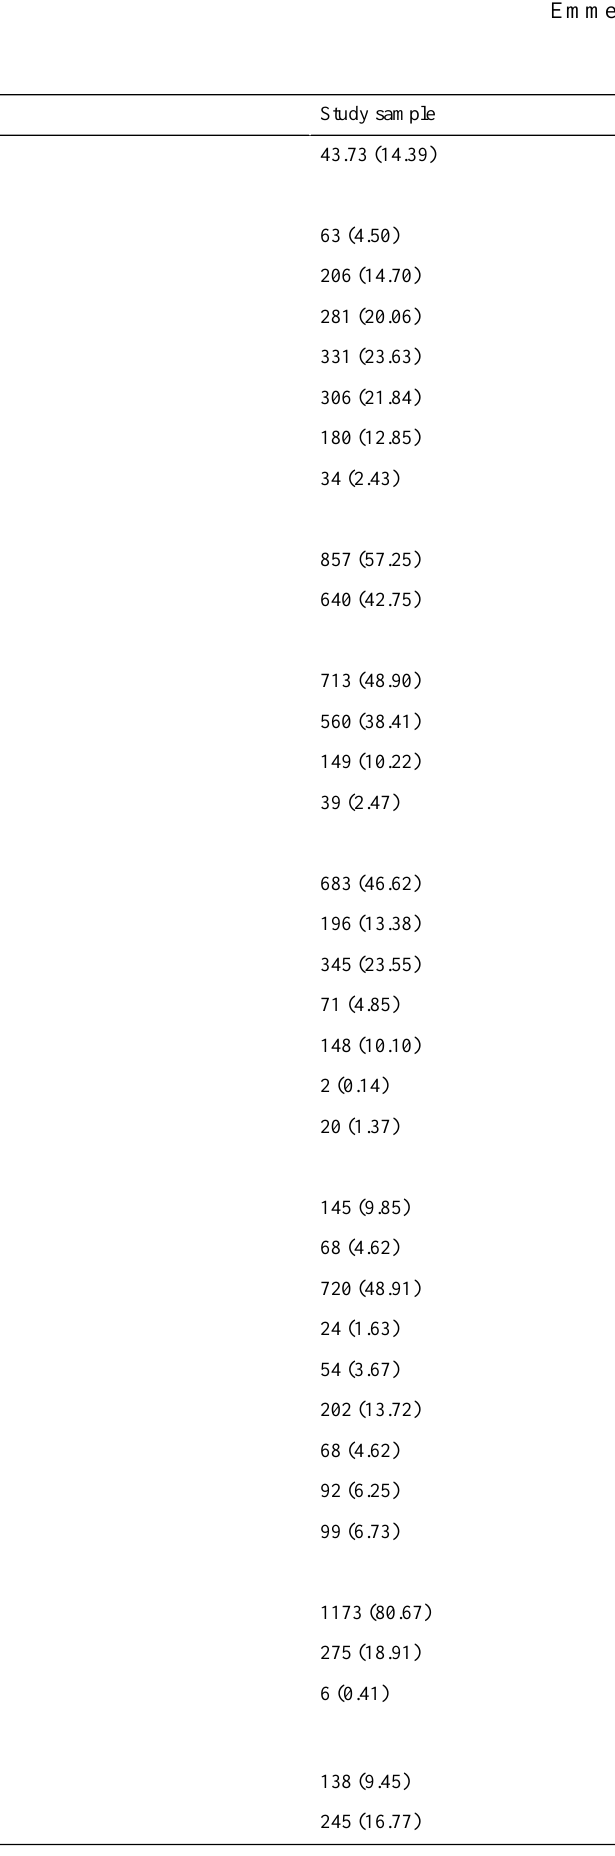
Table 1. Overview of study sample (N=1505).